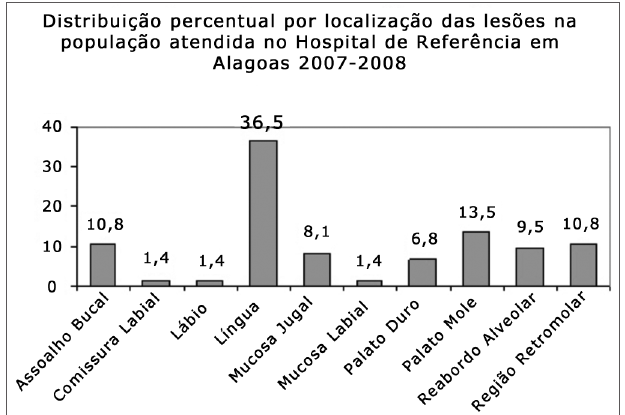
Figura 1. Localização anatômica das lesões.